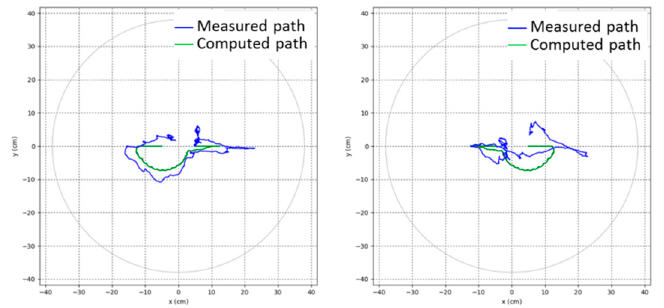
Figure 8. Comparison during two consecutive half stirring periods of the measured and computed paths of the electric arc centroid.